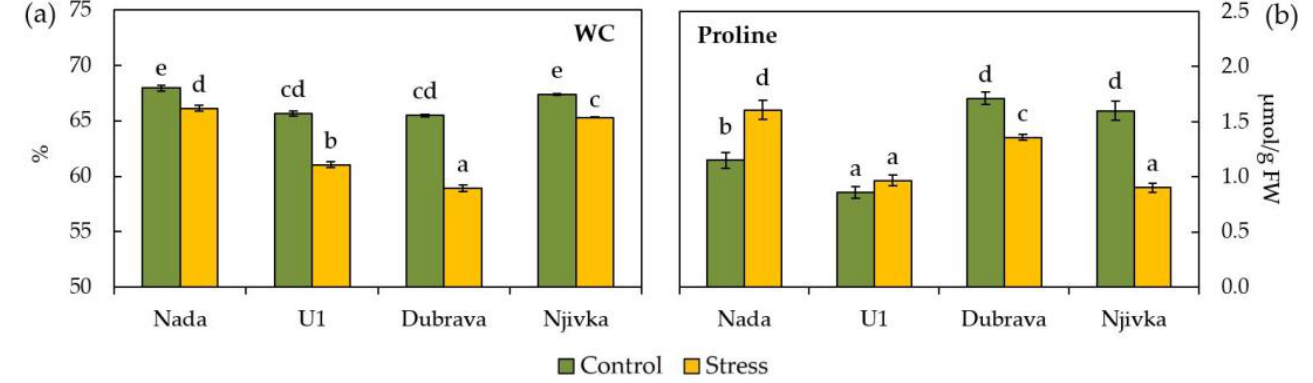
Figure 1. Water content (WC) ( a ) and proline ( b ) in control and drought stressed flag leaves of wheat cultivars. Bars represent mean values ± SE. Different letters indicate significant difference among treatments and cultivars at p < 0.05 according to LSD test.